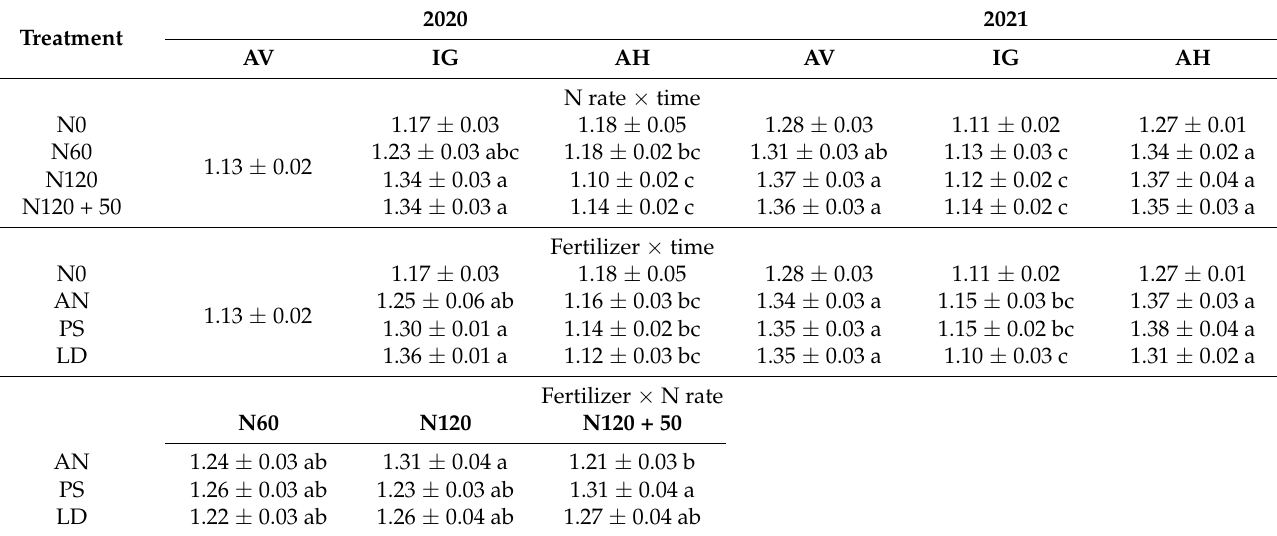
Table 5. Soil total nitrogen (N tot ) variation during winter wheat growing season in g · kg − 1 (0–30